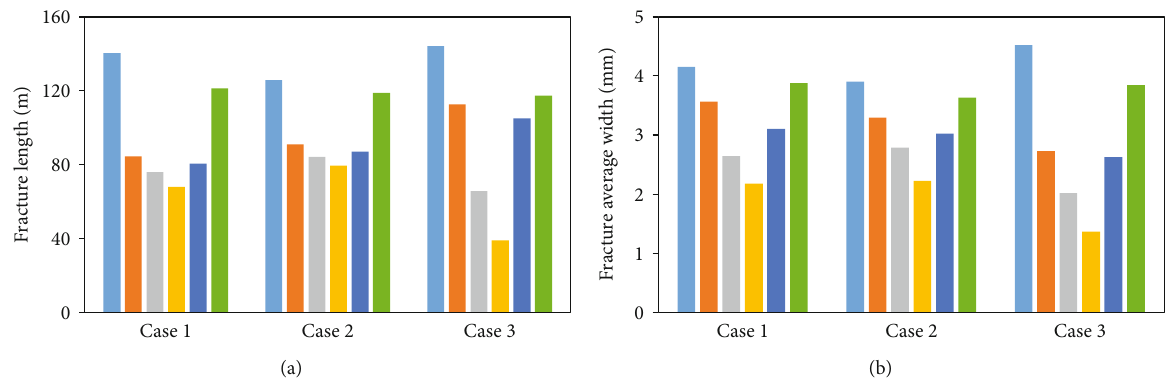
Figure 8: Length (a) and average width (b) of multifracture in a stage with di ff erent perforation